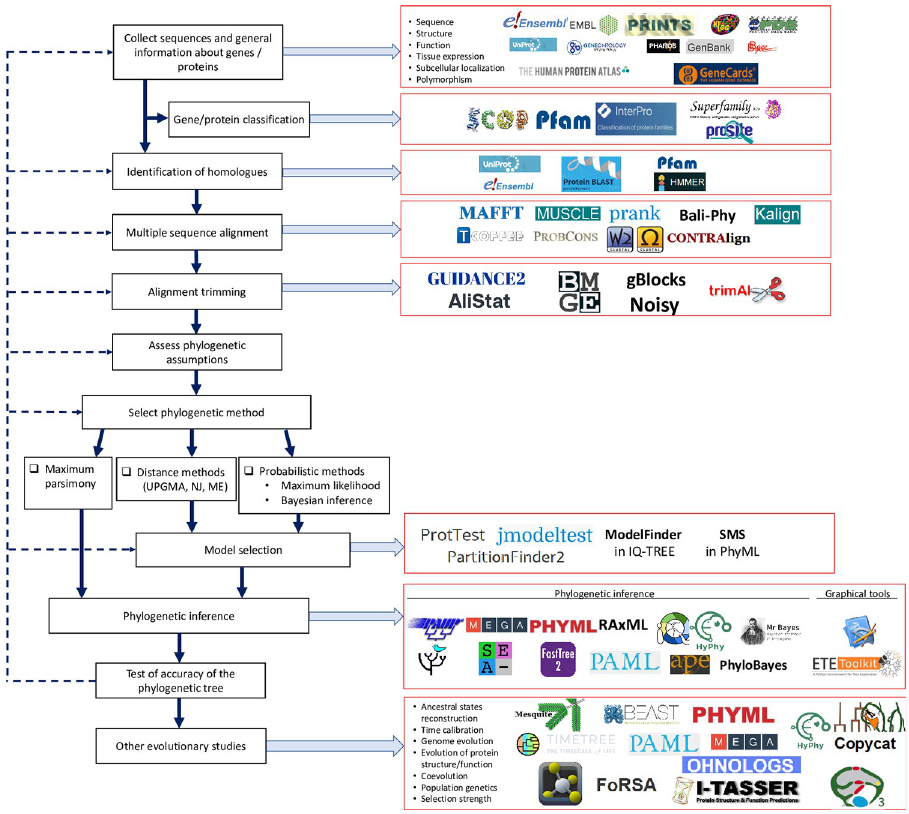
Fig 1. Protocol for reconstructing the phylogeny and evolutionary history of genes and proteins using molecular databases and bioinformatic tools. Solid arrows indicate the order of actions for the phylogenetic analysis and evolutionary studies. Dashed arrows indicate feedback loops that are needed during the process. A subset of available databases and bioinformatic programs are depicted in the figure. This roadmap is mostly based on a recently published phylogenetic protocol [1].